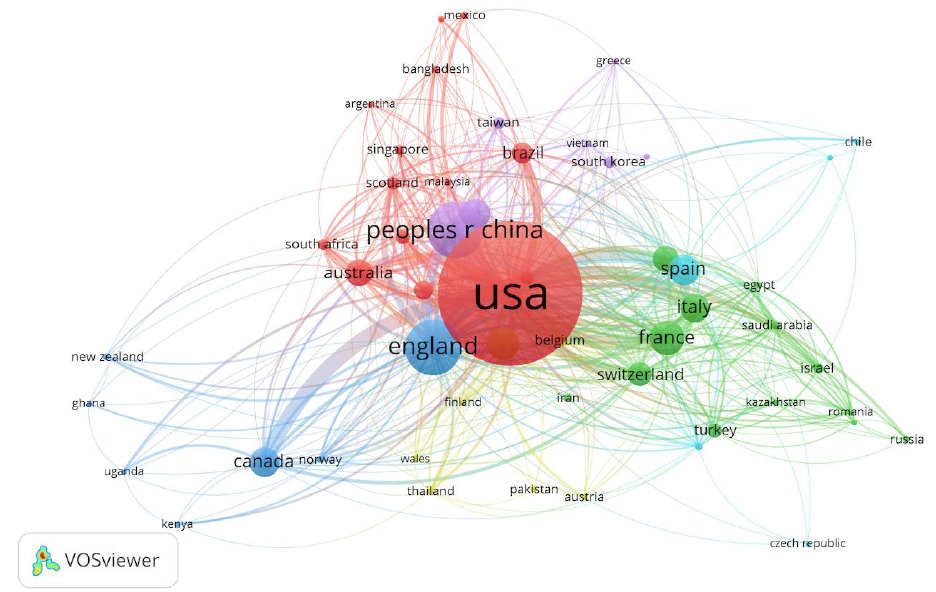
Figure 5. Collaborative network of collaborative countries/regions in the field of the prediction of infectious diseases. Table 2. The top 10 collaborative countries/regions in the field of the prediction of infectious diseases.